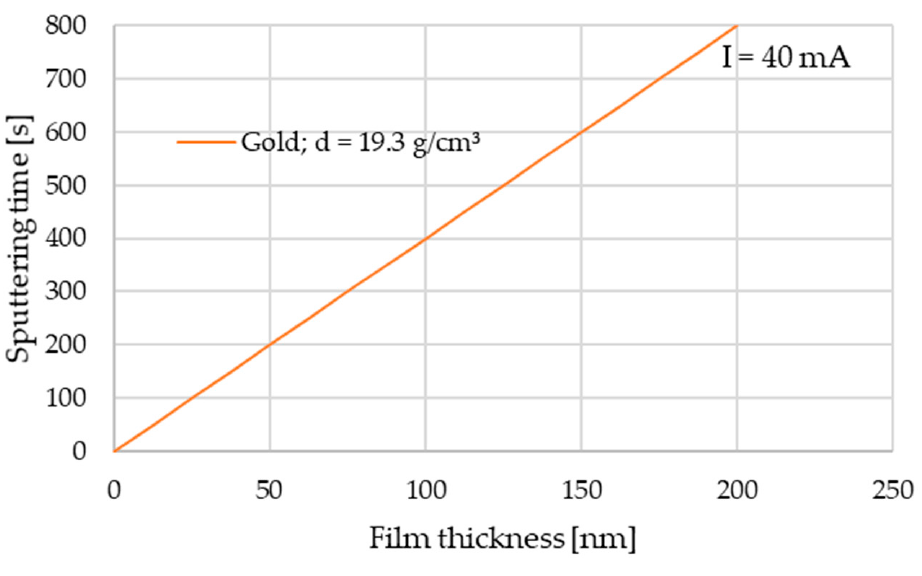
Figure 1. Sputtering time diagram [32].